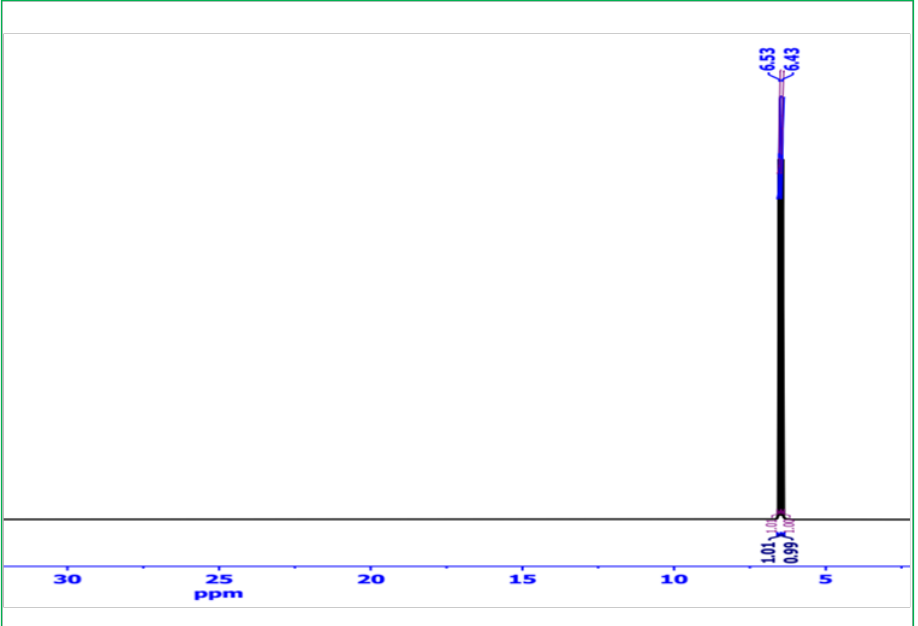
Figure 5. 31 P-NMR analysis of HNAP/QA.